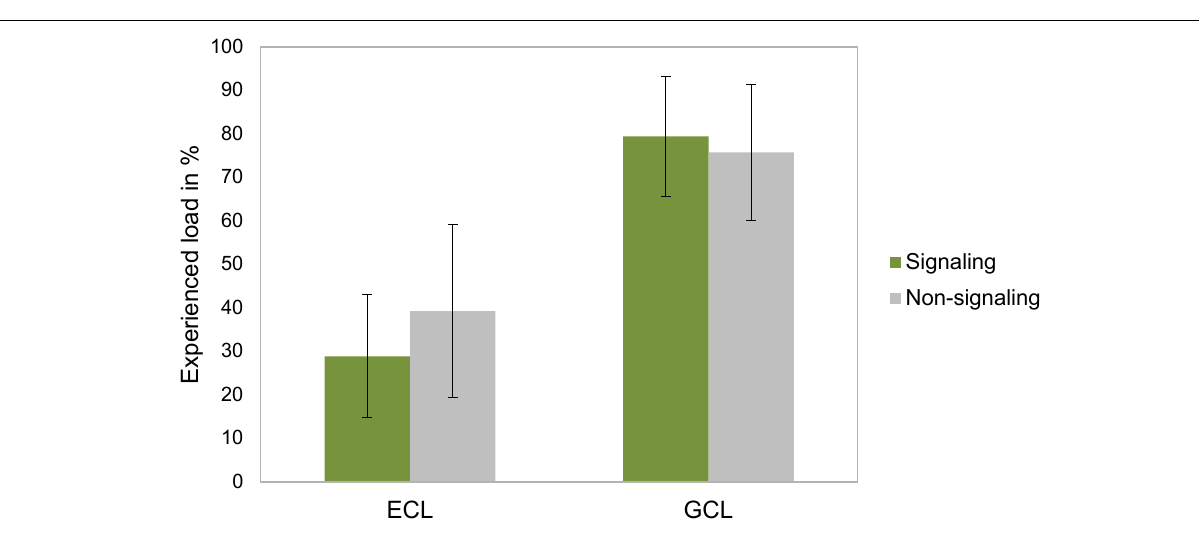
FIGURE 2 | Mean values (in percent) for the learning outcomes recall, comprehension and transfer, separately for the signaling and non-signaling group. The vertical error bars indicate the standard error of the mean.